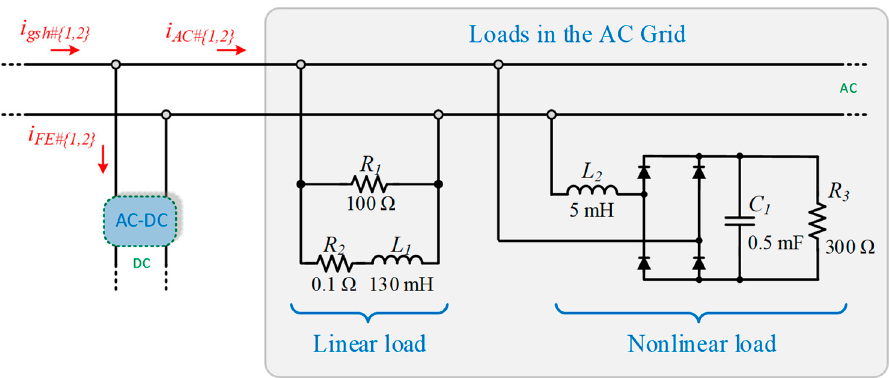
Figure 7. Linear and nonlinear loads considered in the experimental validation, connected to the AC grid, and permitting an operation with reactive power and currents with harmonic content.